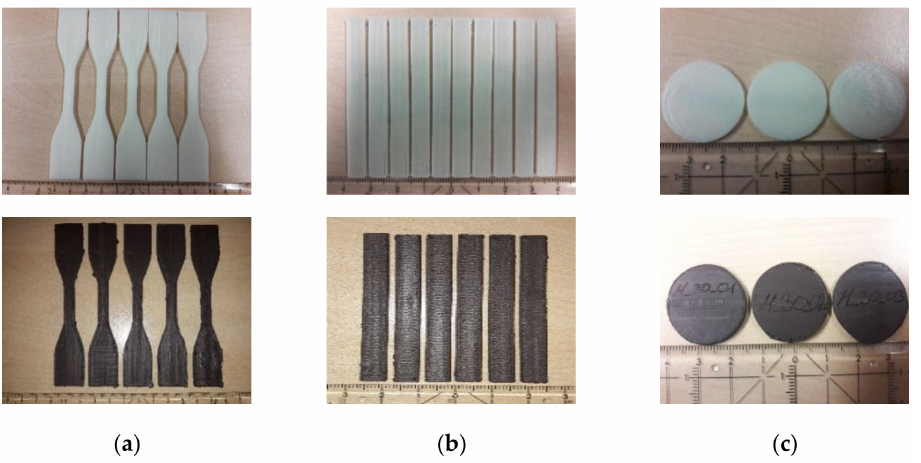
Figure 5. Printed test specimen, upper row pure ABS, lower row composite with 30 vol.% ferrite: ( a ) Tensile test; ( b ) Bending test; ( c ) Magnetic measurement.